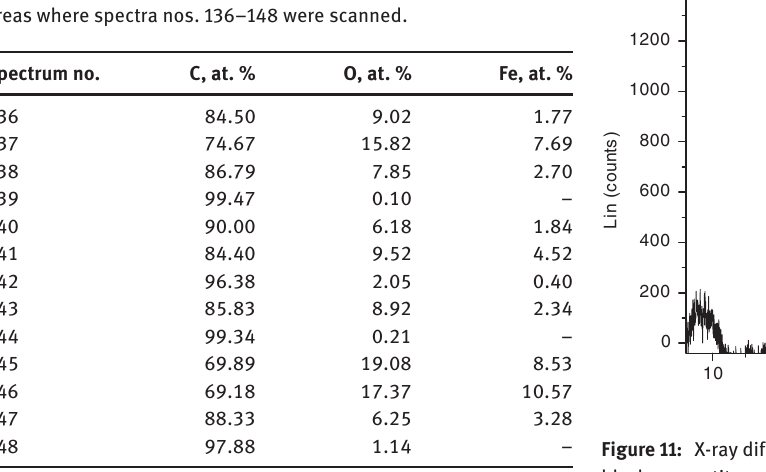
Figure 11: X-ray diffraction pattern of the physical mixture carbon black-magnetite.